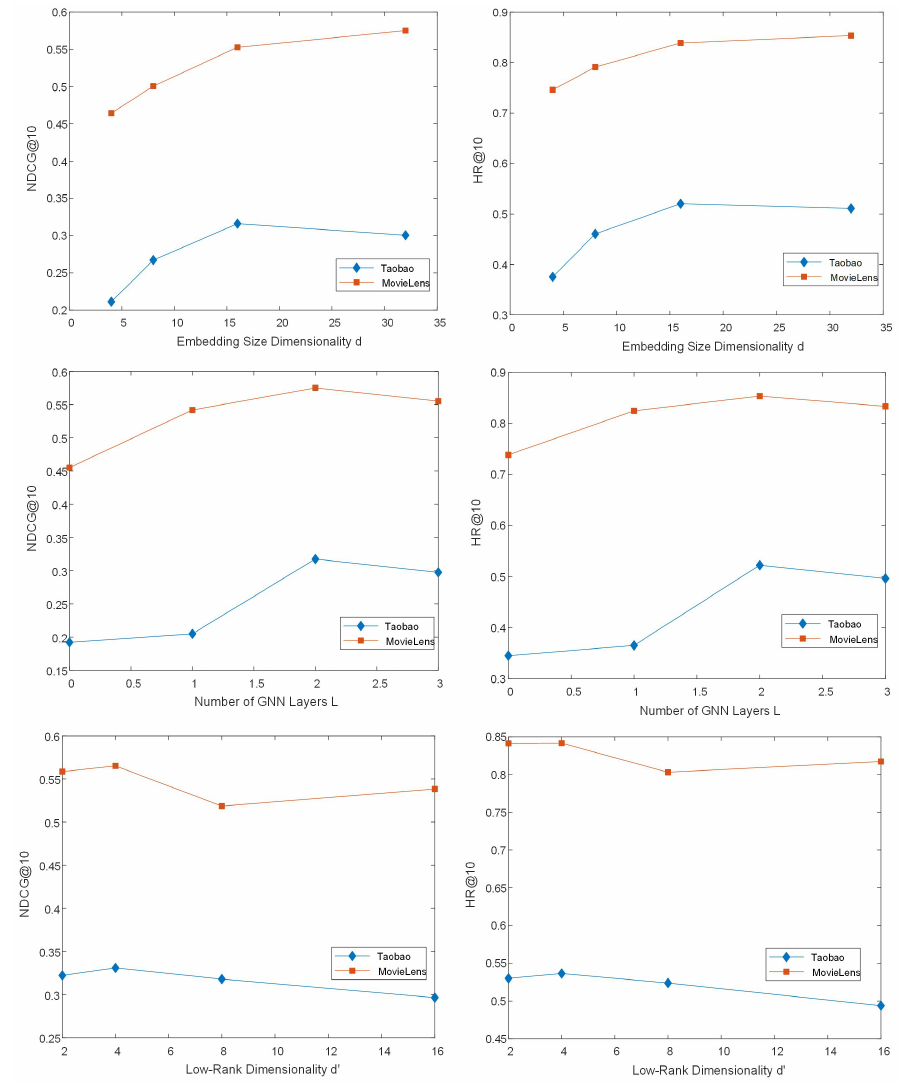
Figure 4. Hyperparameter study on the explainability of